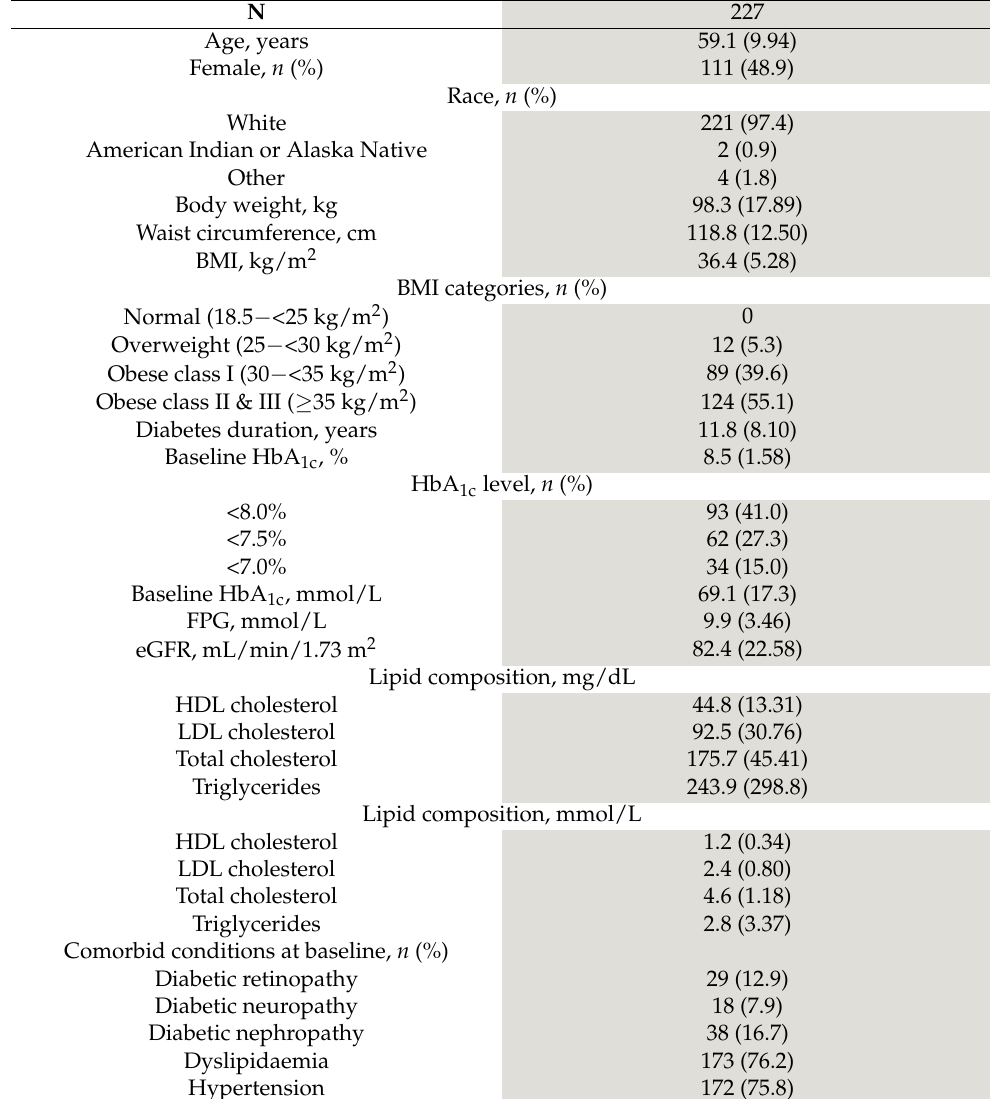
Table 1. Baseline characteristics of patients